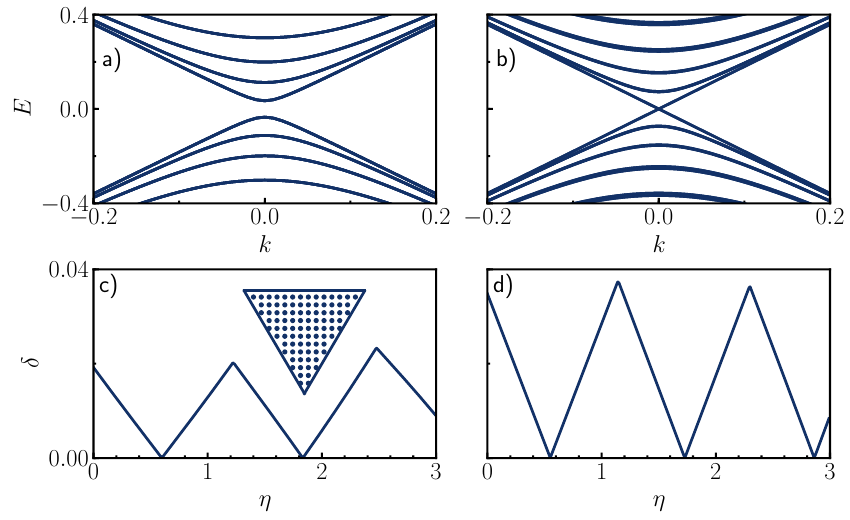
Figure 4: Spectra of the triangular topological insulator nanowire shown in the inset to c), obtained in the tight binding model with ∆ = µ = 0, in the presence of magnetic flux at a) zero flux and b) η = 0.6 where it becomes gapless. The flux required for closing the gap is larger than 0.5 due to finite size effects. c) Gap as a function of flux for the same triangular wire, showing several zeros. d) Gap as a function of flux for = N = 10, showing zeros at different positions due to finite a square wire with N x y size